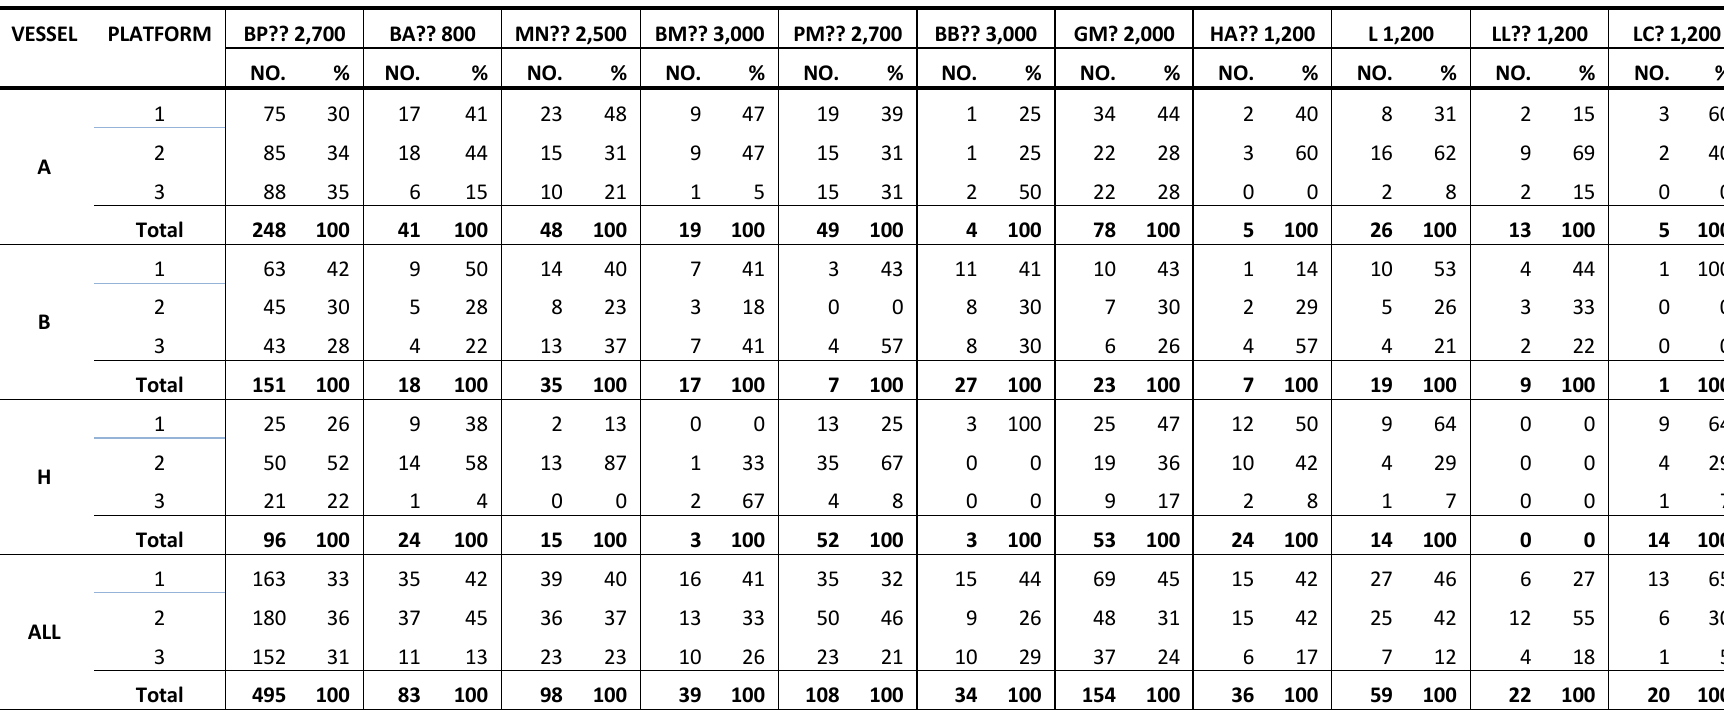
Table 4. Sightings of cetaceans by vessel and platform at the truncation distance indicated besides the species identification. See Table 2 for species definitions. Platform 1: top on vessels A and B, port on vessel H. Platform 2: lower on vessels A and B and starboard on vessel H. Platform 3: duplicate